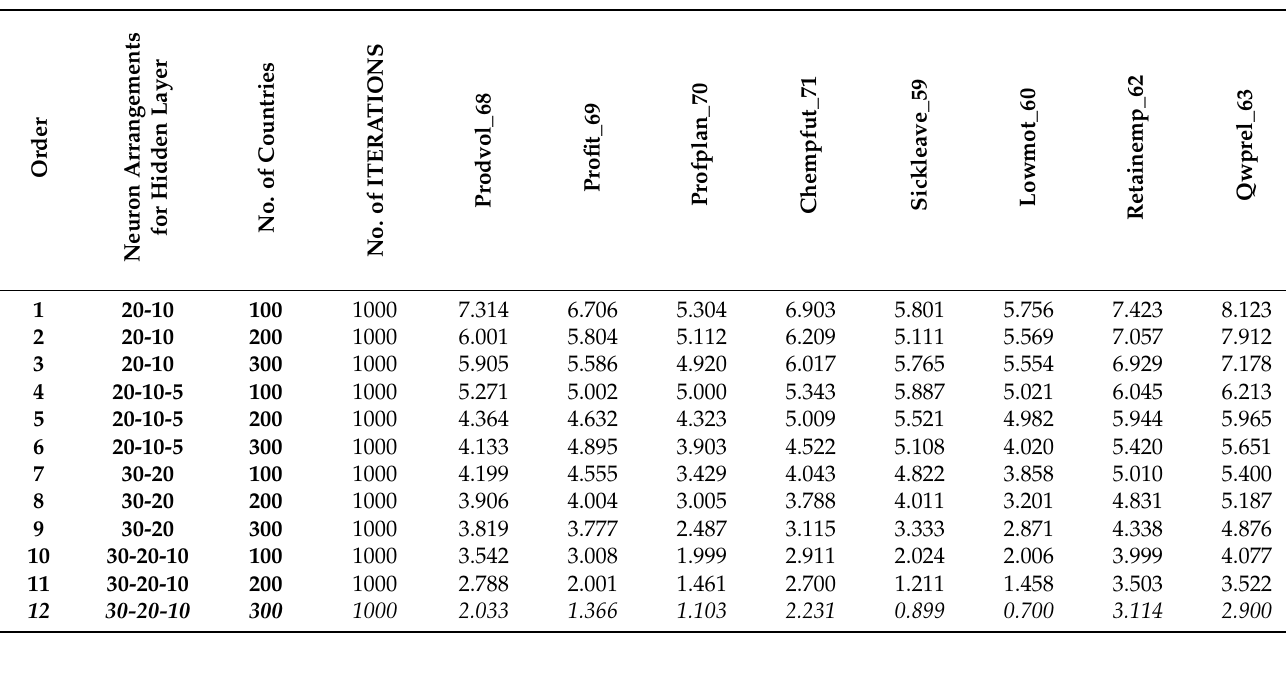
Table 1. Training MAPE for the effect of work organization on outputs.